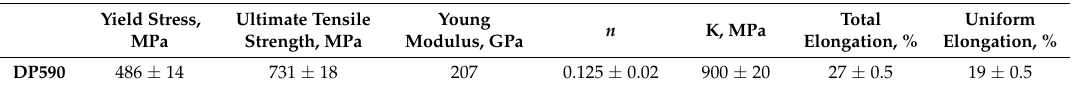
Table 2. Mechanical properties of